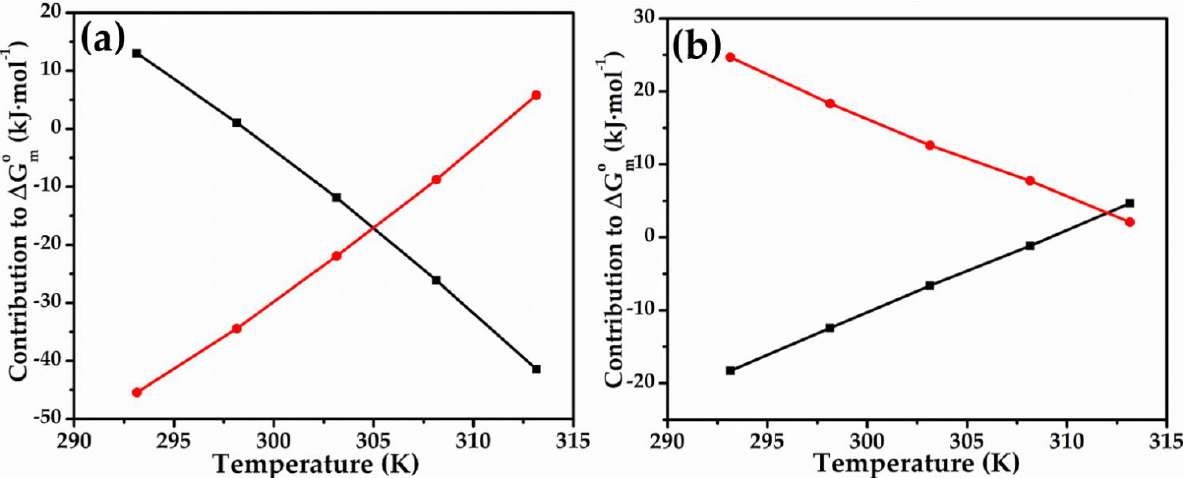
Figure 4. Illustrative plots of contribution of enthalpy, 𝛥𝐻 𝑚𝑜 ( ■ ) and entropy, −𝑇𝛥𝑆 𝑚𝑜 (●) to 𝛥𝐺 𝑚𝑜 of ( a ) NaC and ( b ) NaDC in 0.10 mol∙kg -1 aqueous glycyl dipeptide. Table 4. Counter ion dissociation, α and thermodynamic parameters, ∆ H 0 m (kJ · mol − 1 ), ∆ S 0